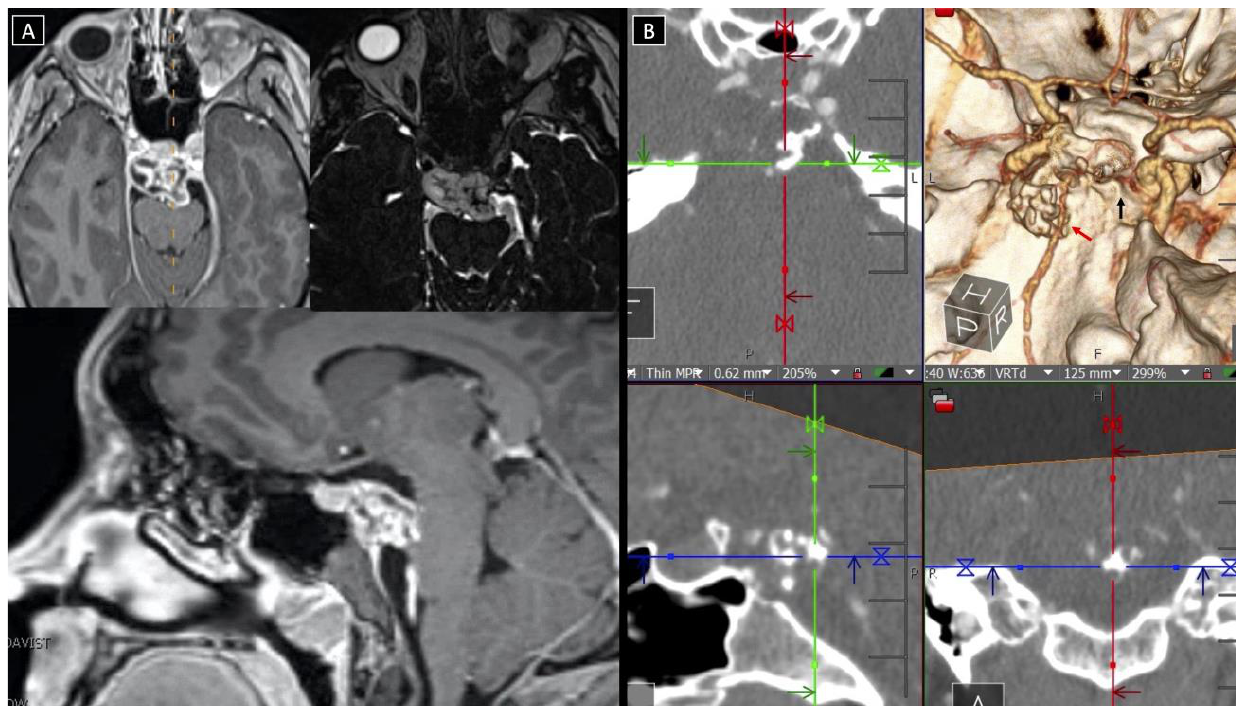
Figure 2. ( A ) MRI showering an upper clival contrast-enhancing lesion with mass effect on the brainstem and basilar artery and intradural extension, ( B ) CTA (axial, coronal, sagittal, and 3D reconstruction) showing the extent of intra-tumor calcifications, the proximity to the basilar system (red arrow), and the erosion of the posterior clinoid process (black arrow).